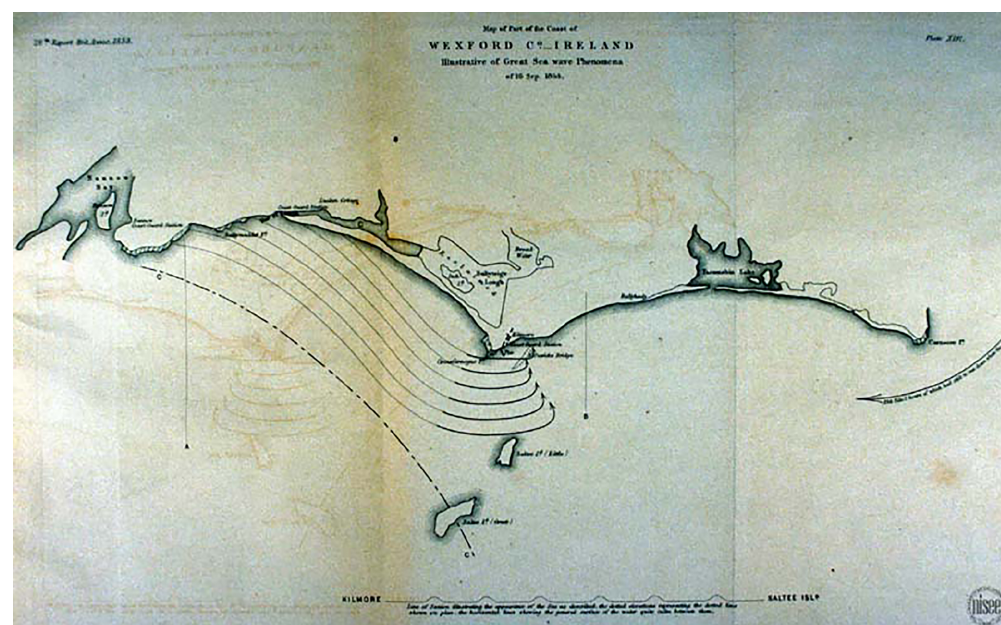
Figure 4. A tsunami at Kilmore Quay on 16 September 1854 (Mallet and Mallet, 1854).